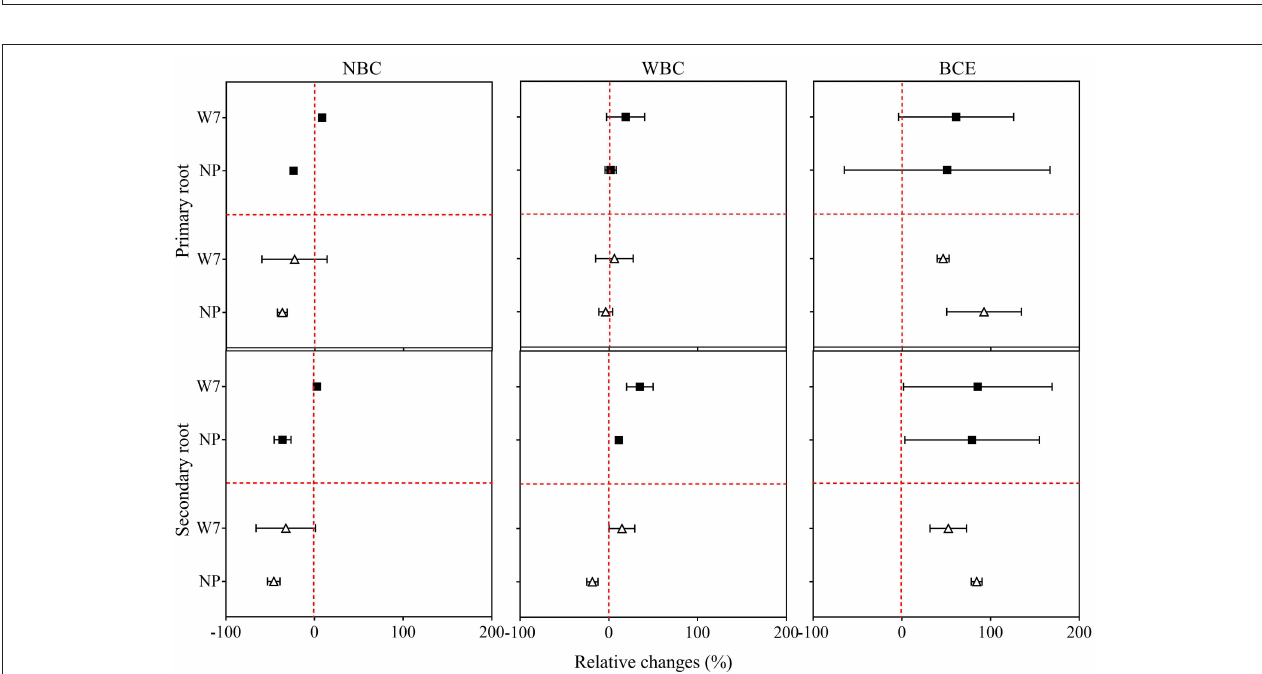
FIGURE 2 | Relative changes in primary and secondary root length of Wuyunjing 7 and Nipponbare with NBC, WBC, and BCE at a dosage of 0.05% (solid square) and 0.1% (hollow triangle) in Experiment 1 ( n = 4).